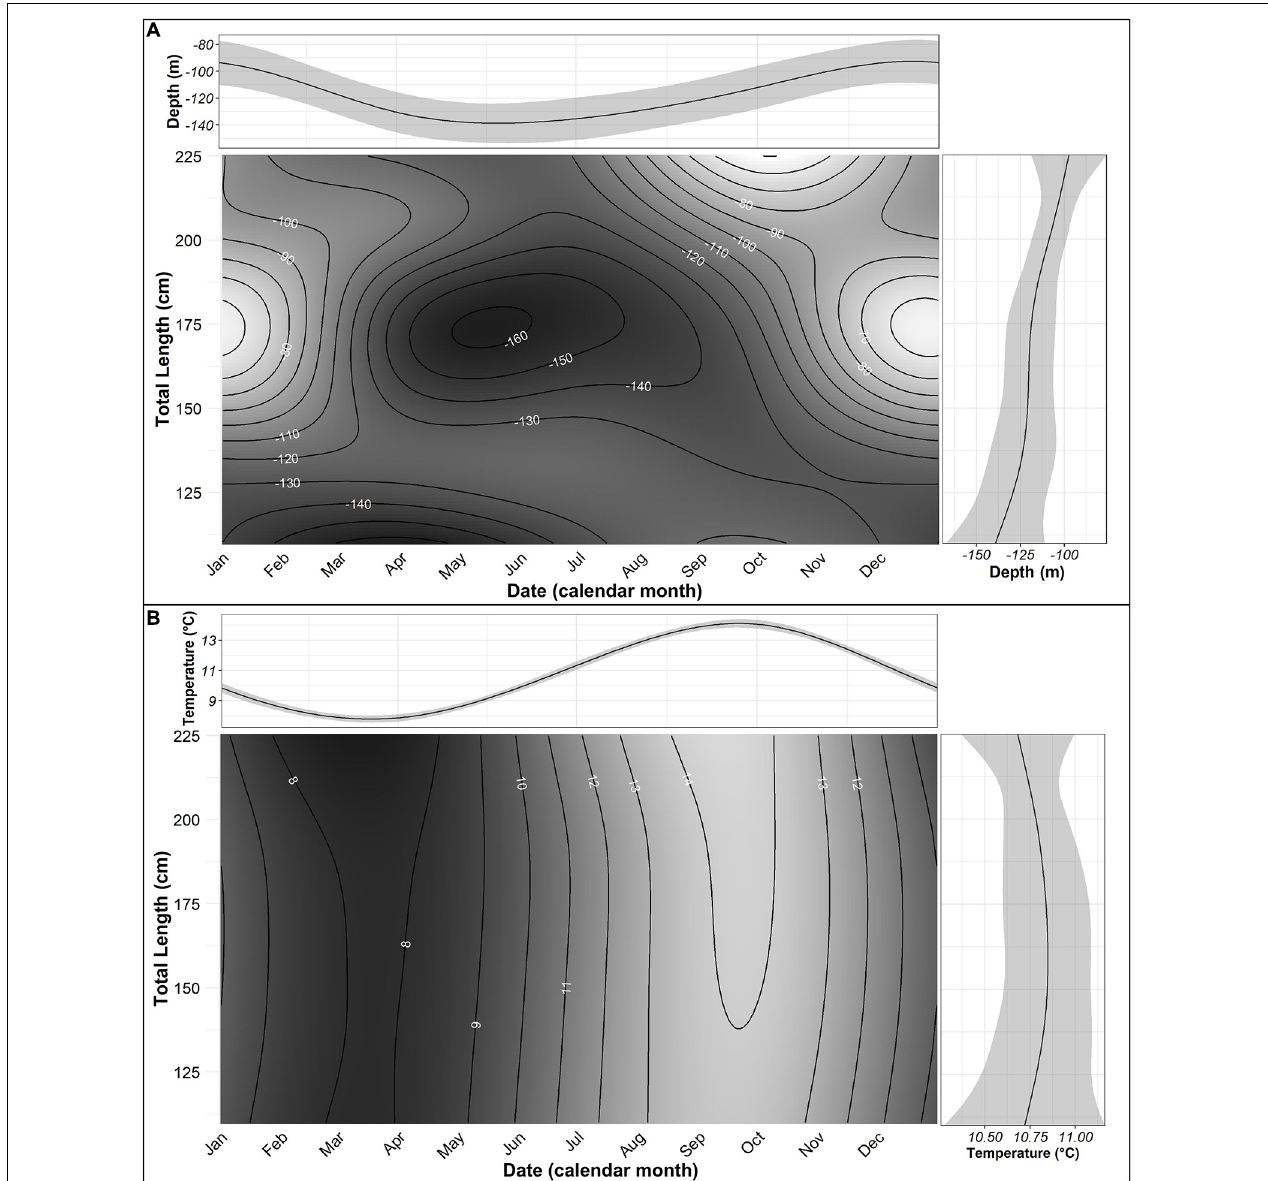
FIGURE 4 | Generalised additive mixed model predictions for depth (A) and temperature (B) in relation to total length and Julian day. In A,B , top and side panels show the expected value of the response in relation to Julian day and total length, respectively, with 95% confidence bands. The main panel shows the expected value in relation to both terms. Model coefficients are given in Table 2